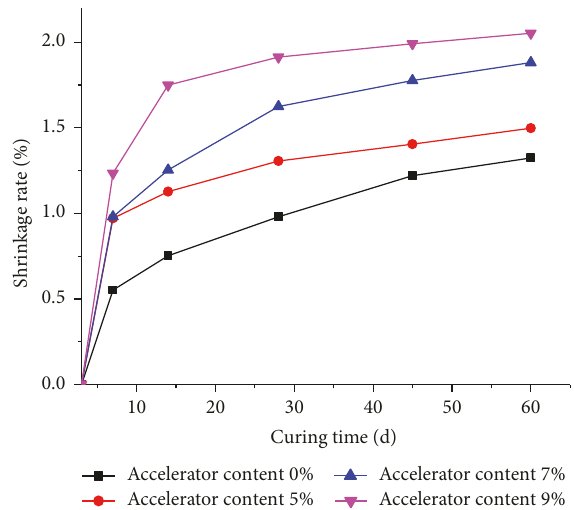
Figure 4: The effect of accelerator on shrinkage rate.